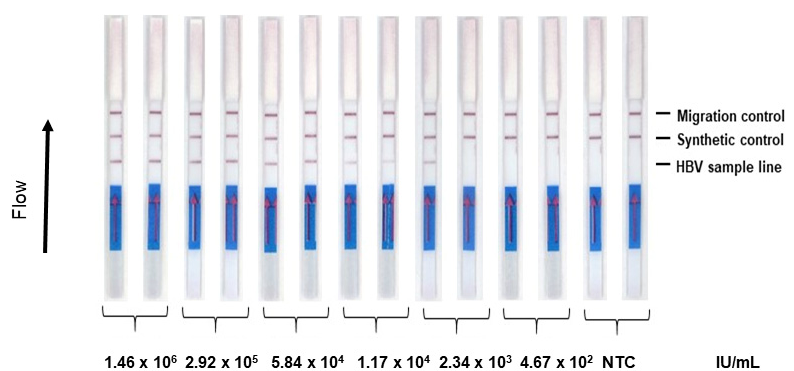
Figure 3. Detection limit of the HBV RPA-LFA (50 µ L). To determine the detection limit of the RPA-LFA (lateral flow assay) in the format of extraction using 50 µ L 5% Chelex 100, five-fold serial dilutions of the standard control ranging from viral loads of 1.46 × 10 6 IU to 4.6 × 10 2 IU/mL were tested. Each dilution was tested in duplicate. NTC refers to non-template control.